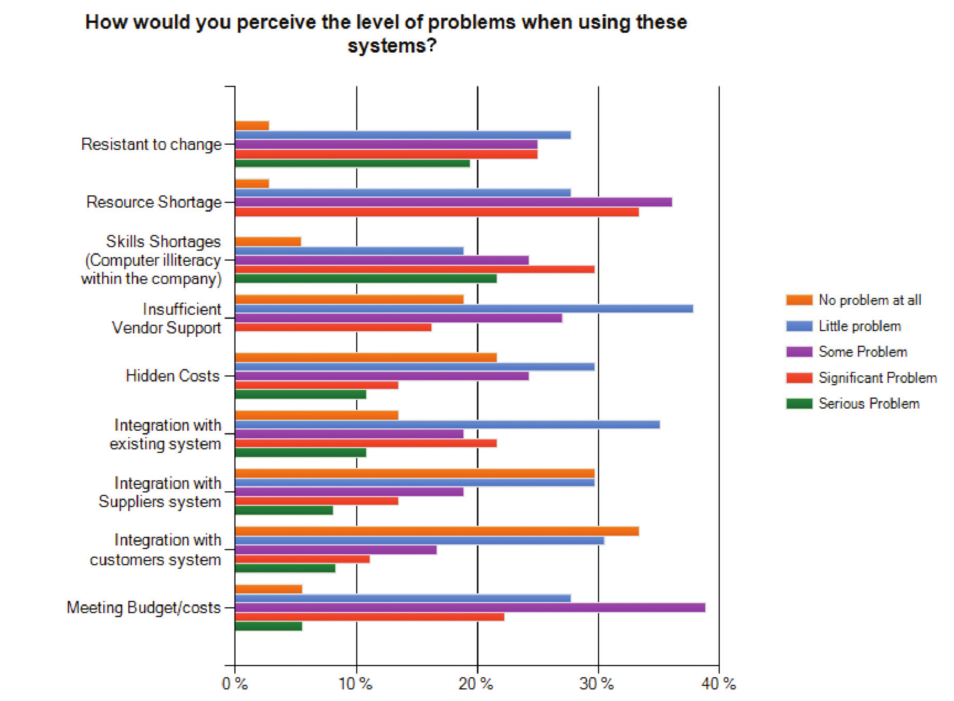
Figure 7: Problems when adopting AIS in the supply